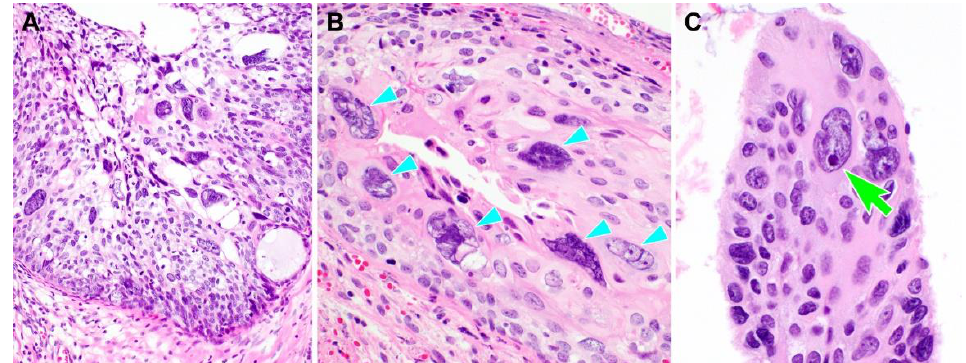
Figure 2. Nuclear features of pleomorphic high-grade squamous intraepithelial lesion (PHSIL). ( A ) Several scattered pleomorphic cells possess large, pleomorphic nuclei and variable amounts of clear or eosinophilic cytoplasm. A small, round residual endocervical lumen is noted (right lower corner). ( B,C ) PHSIL frequently displays ( B ) multinucleation (six light blue arrowheads) and ( C ) conspicuous nucleoli (a light green arrow). Hematoxylin and eosin staining. Original magnification: ( A ) = 200×, ( B ) = 400×, ( C ) = 600×.